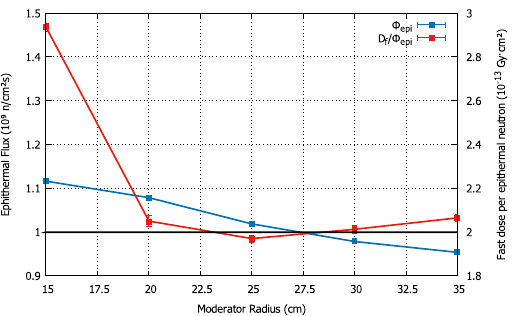
Figure 2. Optimization of the moderator radius for the optimal thickness. The optimal value is found by keeping the epithermal flux (blue line) as high as possible while the fast dose per epithermal flux (red line) is minimized, which happens at a radius of 25